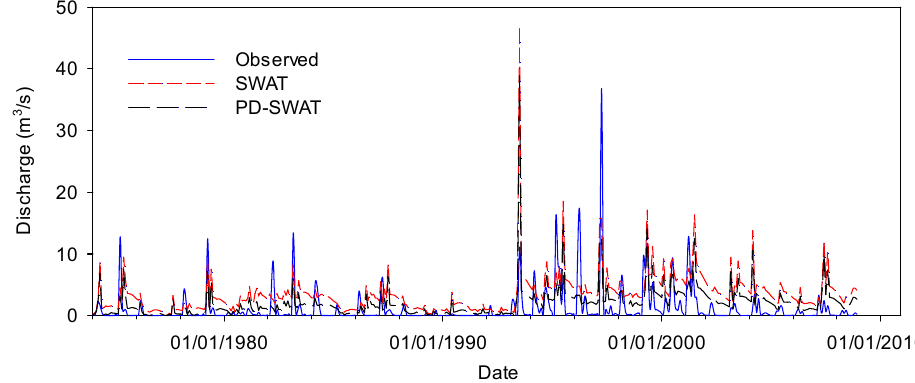
Figure 5. Comparison of observed and simulated hydrographs by SWAT and PD ‐ SWAT for the large watershed.